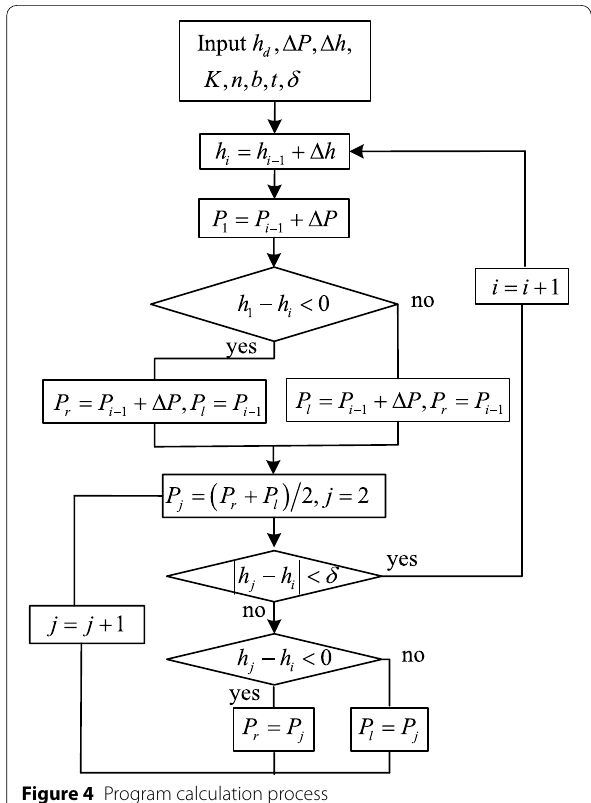
Figure 4 Program calculation process